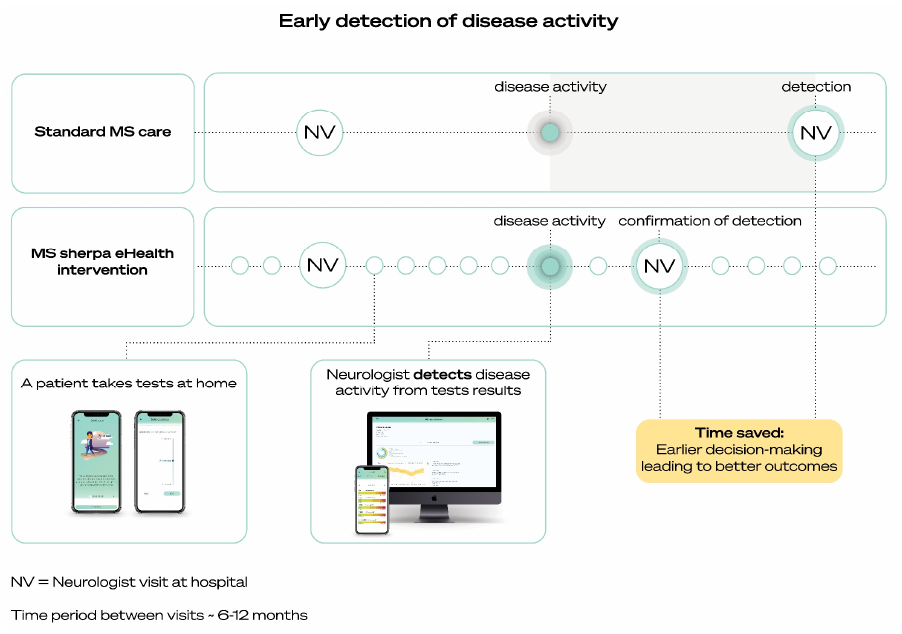
Figure 1. Graphical representation of the MS sherpa